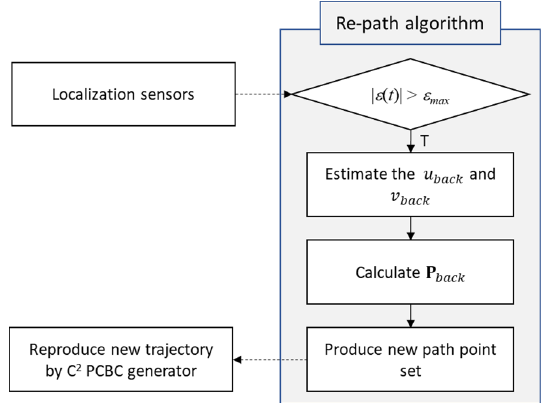
Figure 8. Re-path algorithm flow chart.